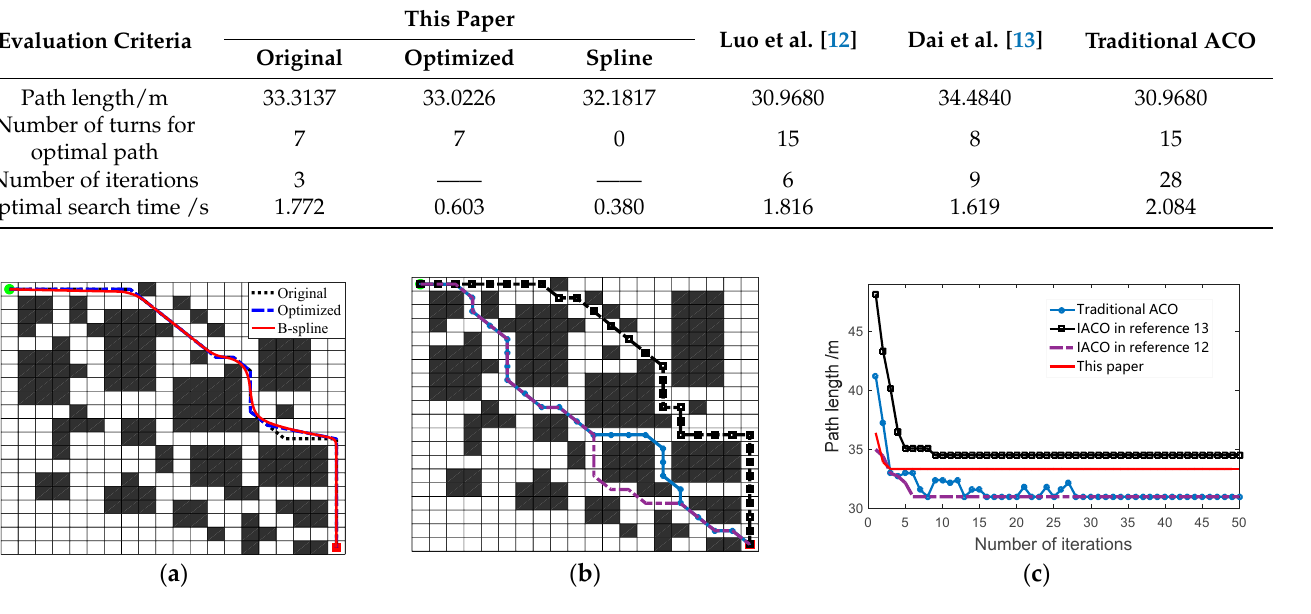
Table 5. Performance comparison table for U-shaped environment algorithms.